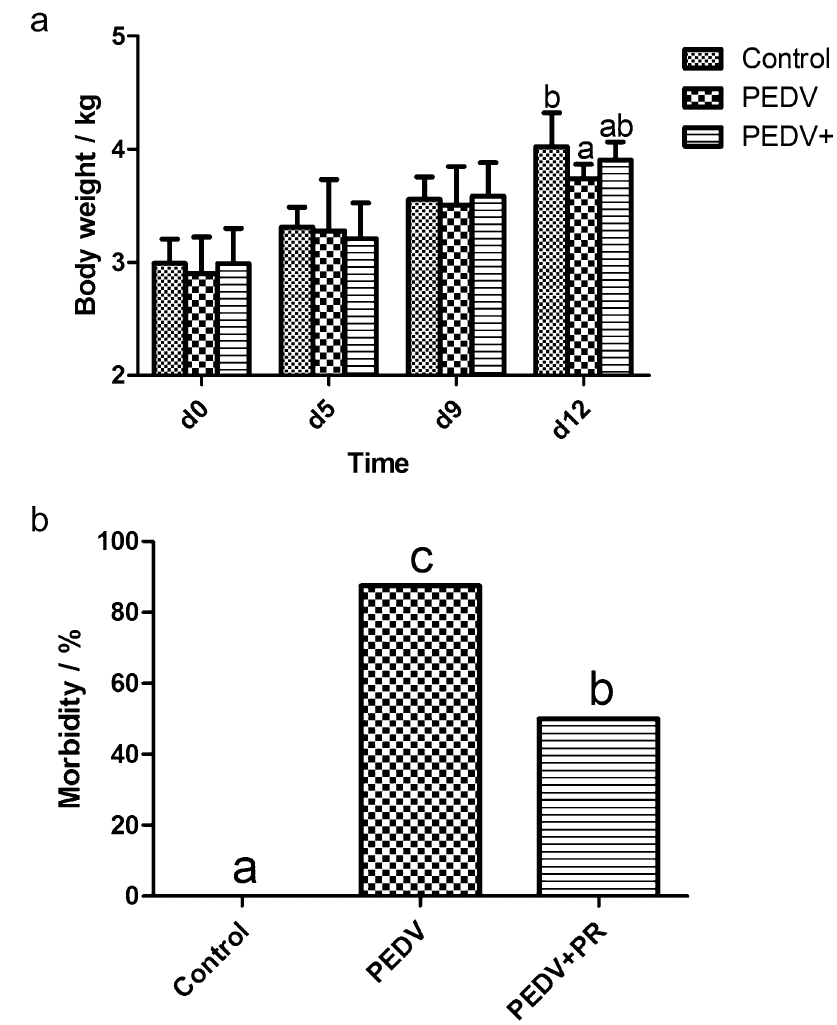
Figure 1. Effects of puerarin (PR) administration on body weight and morbidity of piglets after PEDV infection. ( a ) body weight. ( b ) morbidity. Values are mean and SD, n = 8. a, b, c , Values within a column not sharing a common superscript letter indicate significant difference at P <